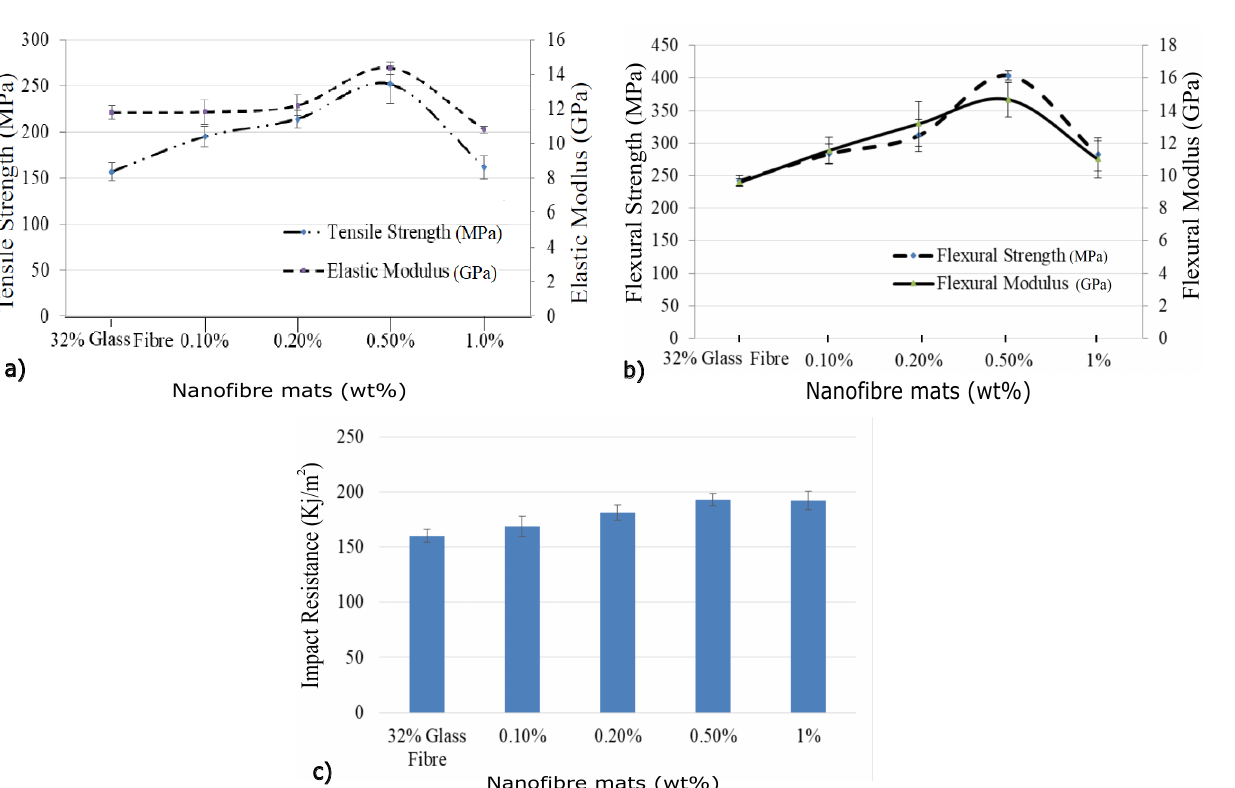
Figure 6. Properties of RONFs mats strengthened hybrid composite: ( a ) tensile properties; ( b ) flexural properties; ( c ) impact